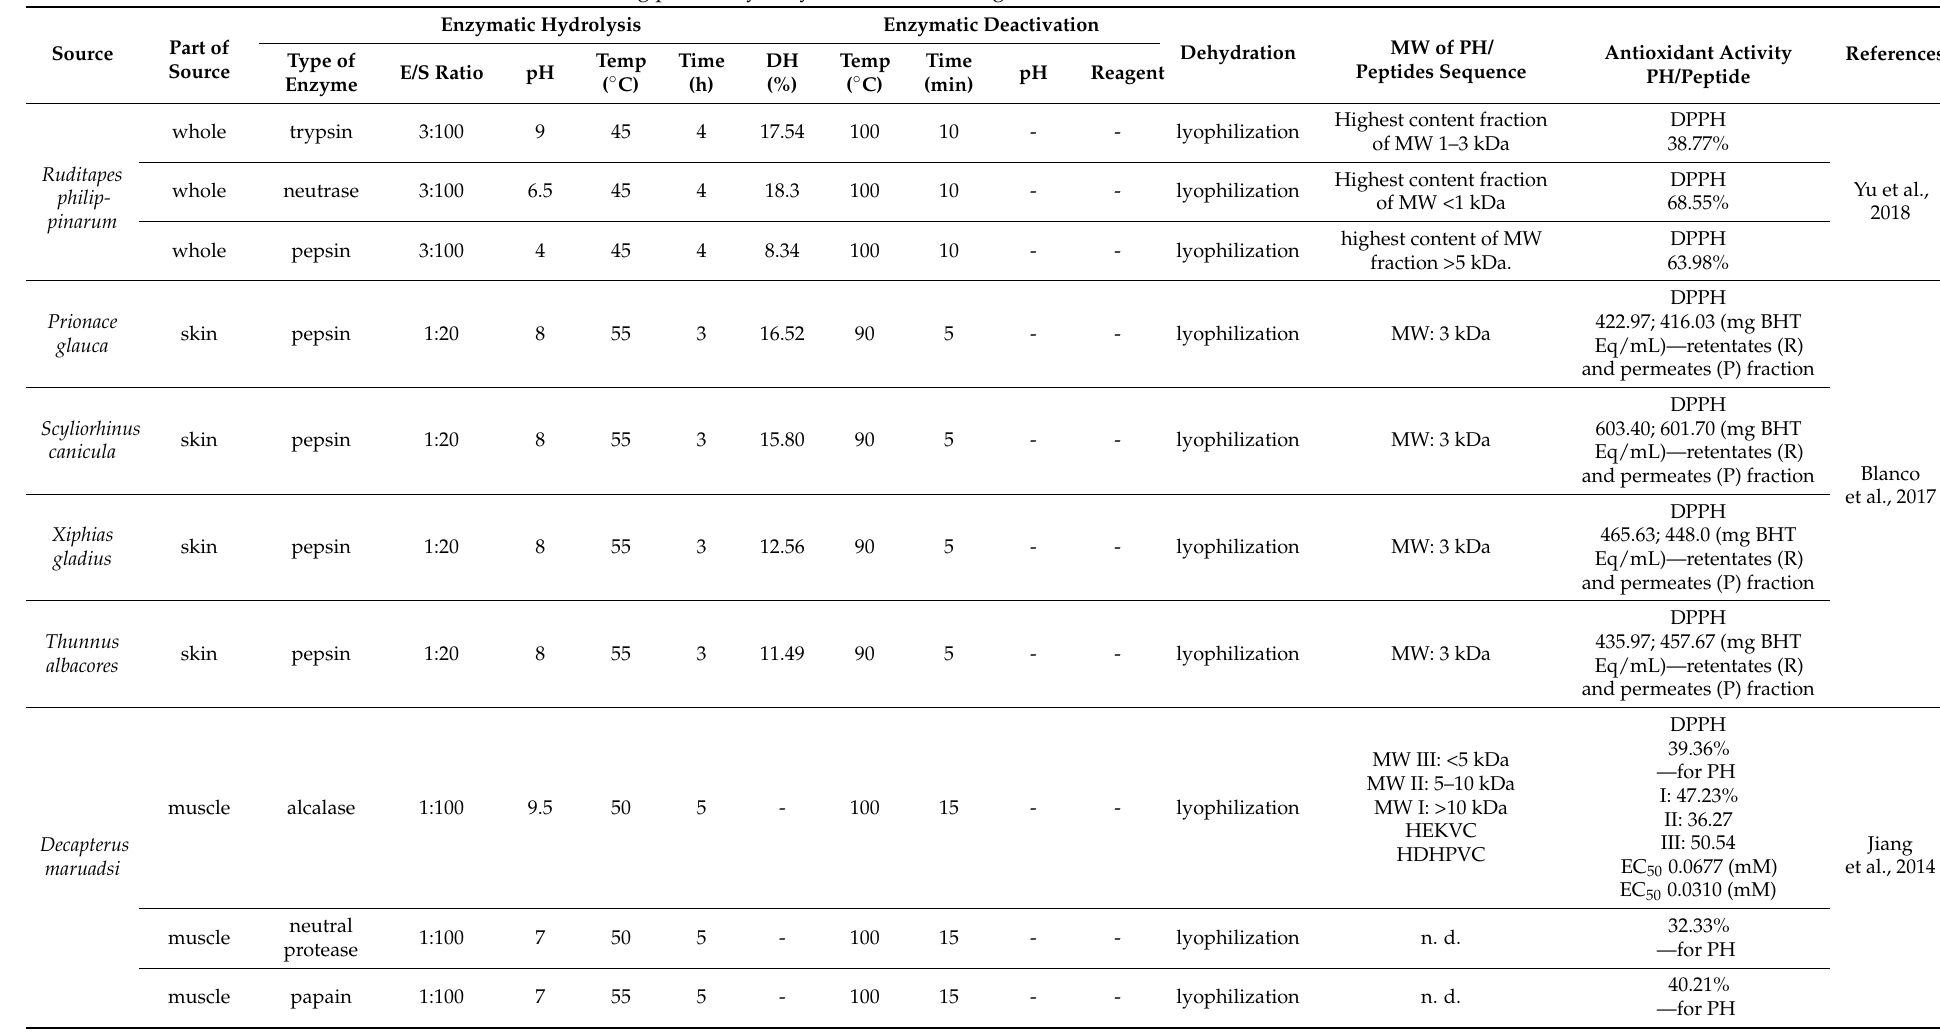
Table 1. Methods of obtaining protein hydrolysates of animal